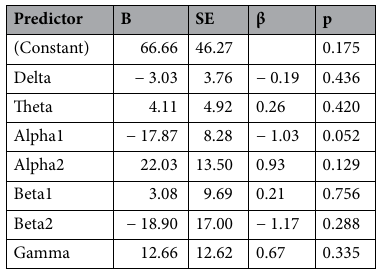
Table 2. Multiple regression analysis for paranormal beliefs based on frequency bands. B The unstandardized beta, SE standard error for the unstandardized beta, β standardized